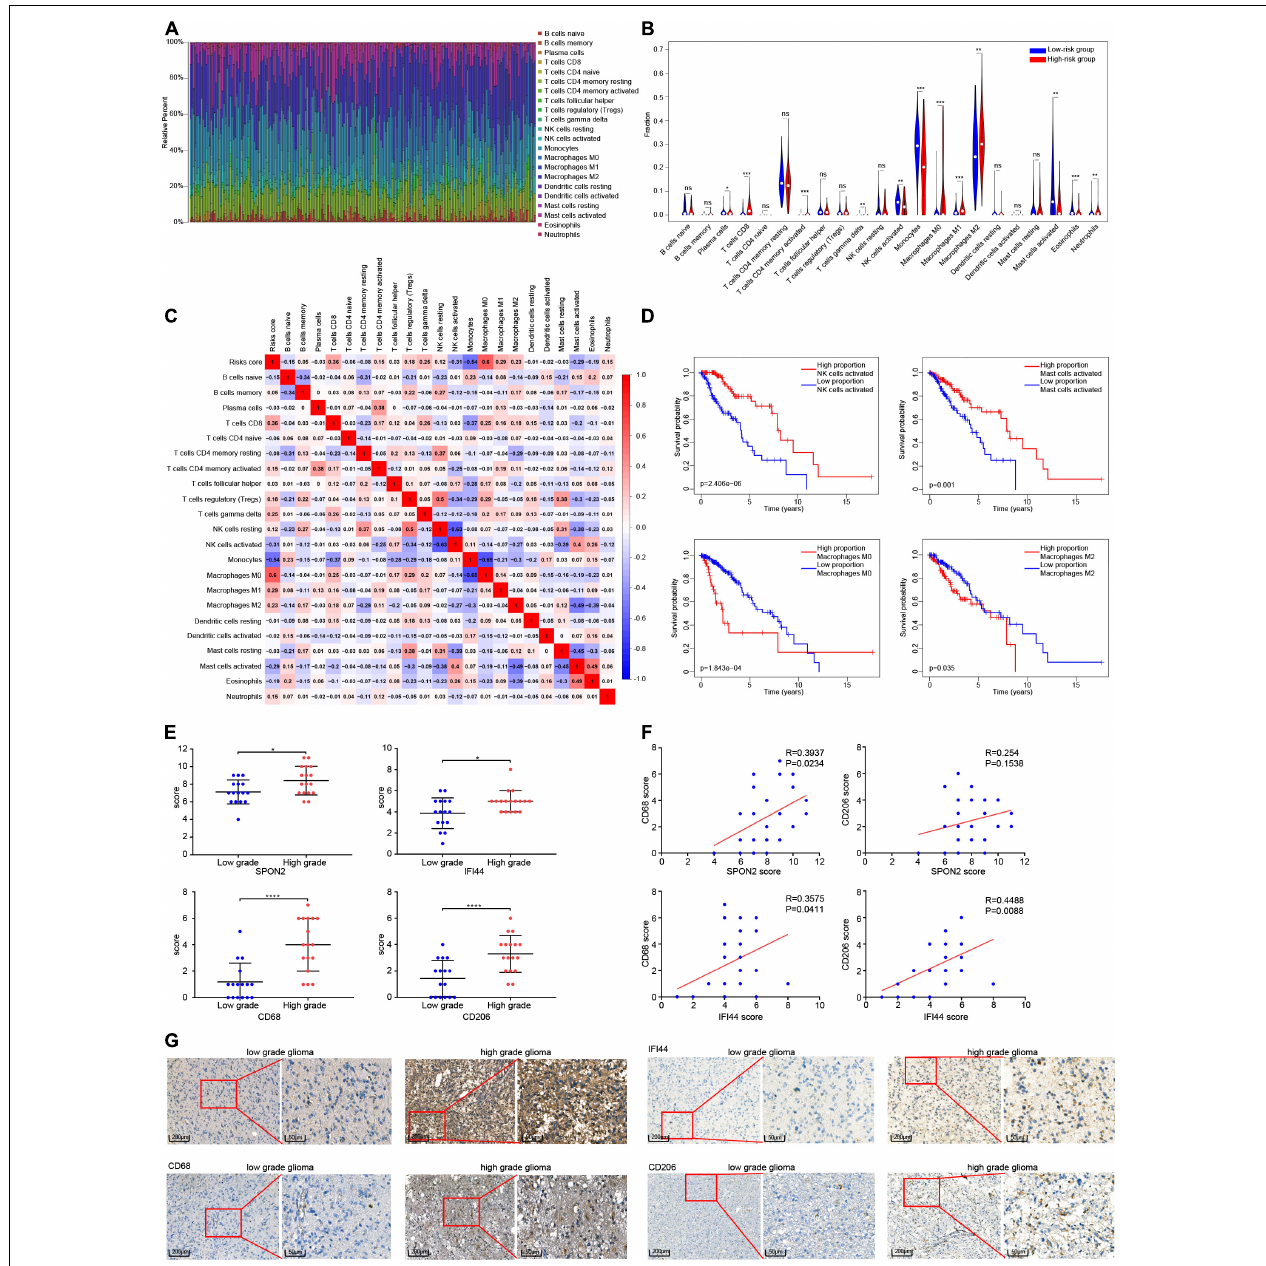
FIGURE 7 | Analysis of the relationship between risk score and immune cell subtypes. (A) Proportion of immune cells in each glioma sample are indicated with different colors, and lengths of the bars in the bar chart indicate the levels of the immune cell proportions. (B) Comparison of the proportion of 22 immune cell types in high and low risk groups. (C) Correlation risk score and the proportion of 22 immune cell types. (D) Survival curves of four immune cell types significantly related to the prognosis of patients with glioma. (E) Comparison of the scoring of SPON2, IFI44, CD68 and CD206 expression in low-and high-grade gliomas tissues. (F) Correlation analysis between the scoring of SPON2, IFI44, CD68 and CD206 expression. (G) Representative immunohistochemistry of low- and high-grade gliomas tissues with the scoring of SPON2, IFI44, CD68 and CD206 expression. Abbreviations: ns, P > 0.05, * P < 0.05, ** P < 0.01, *** P < 0.001, **** P <